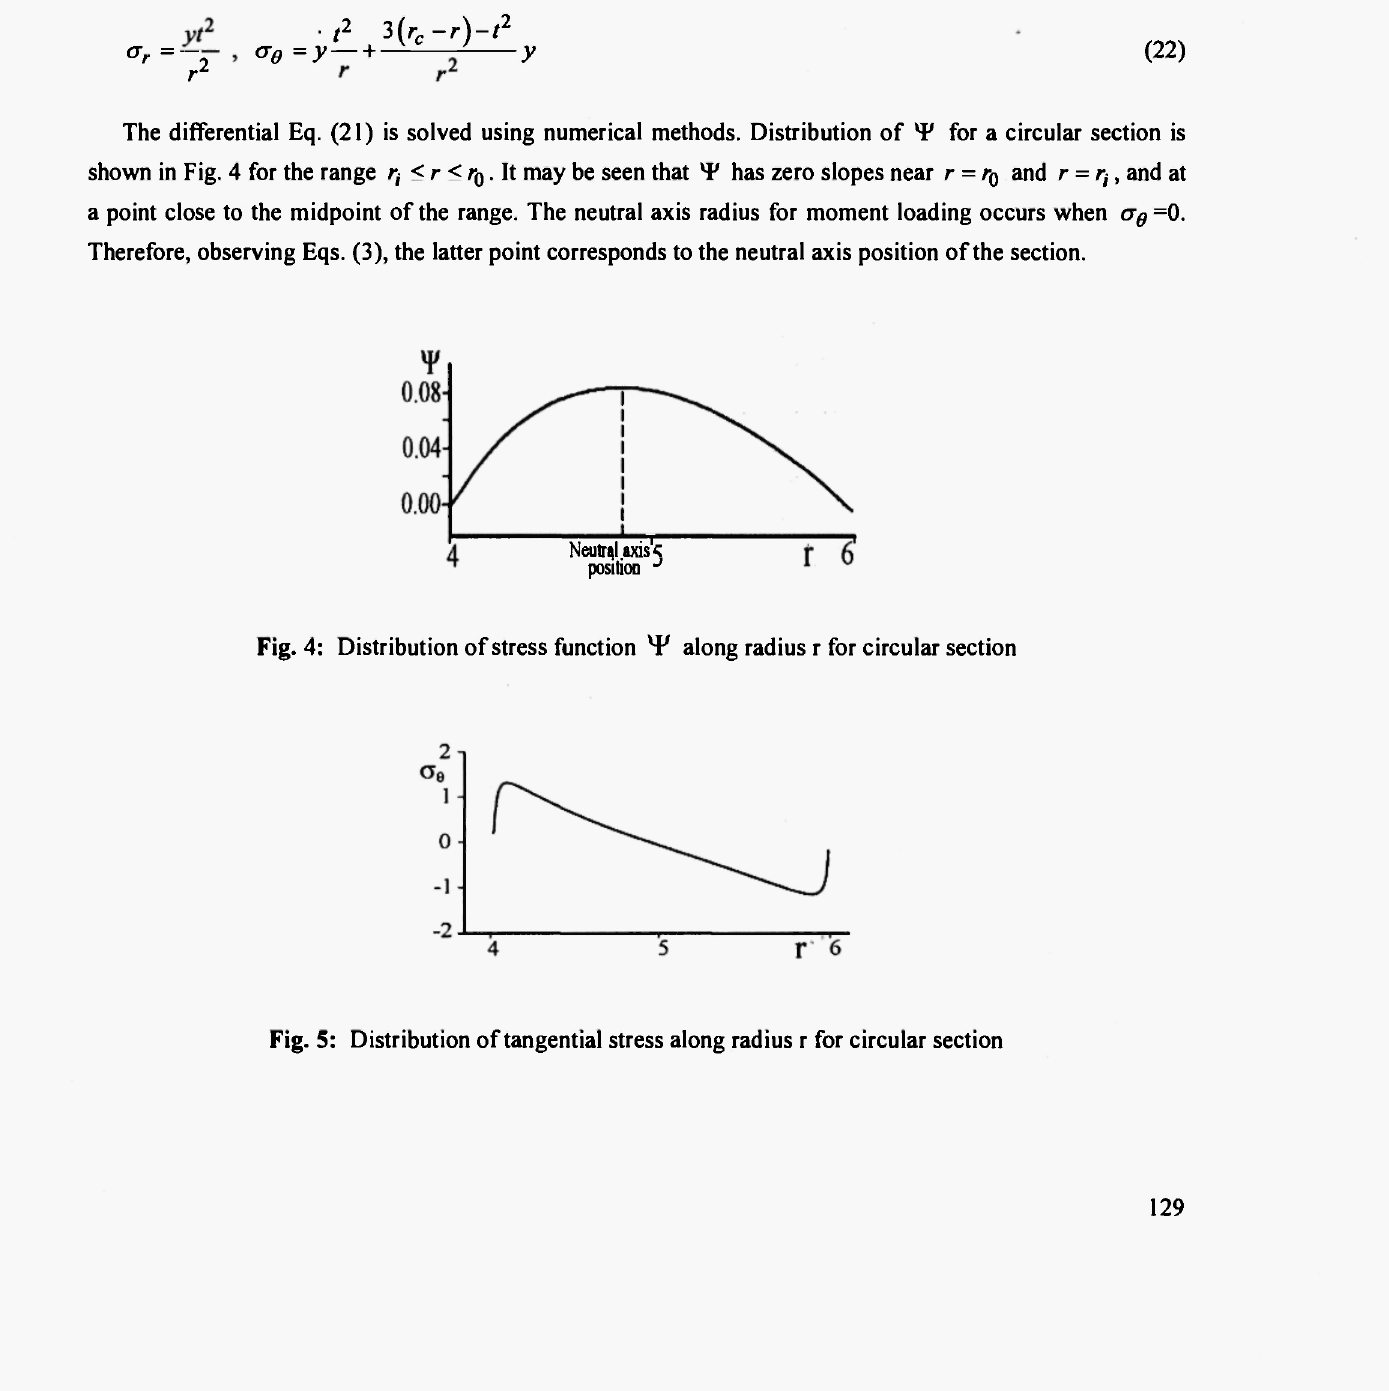
Fig. 5: Distribution of tangential stress along radius r for circular